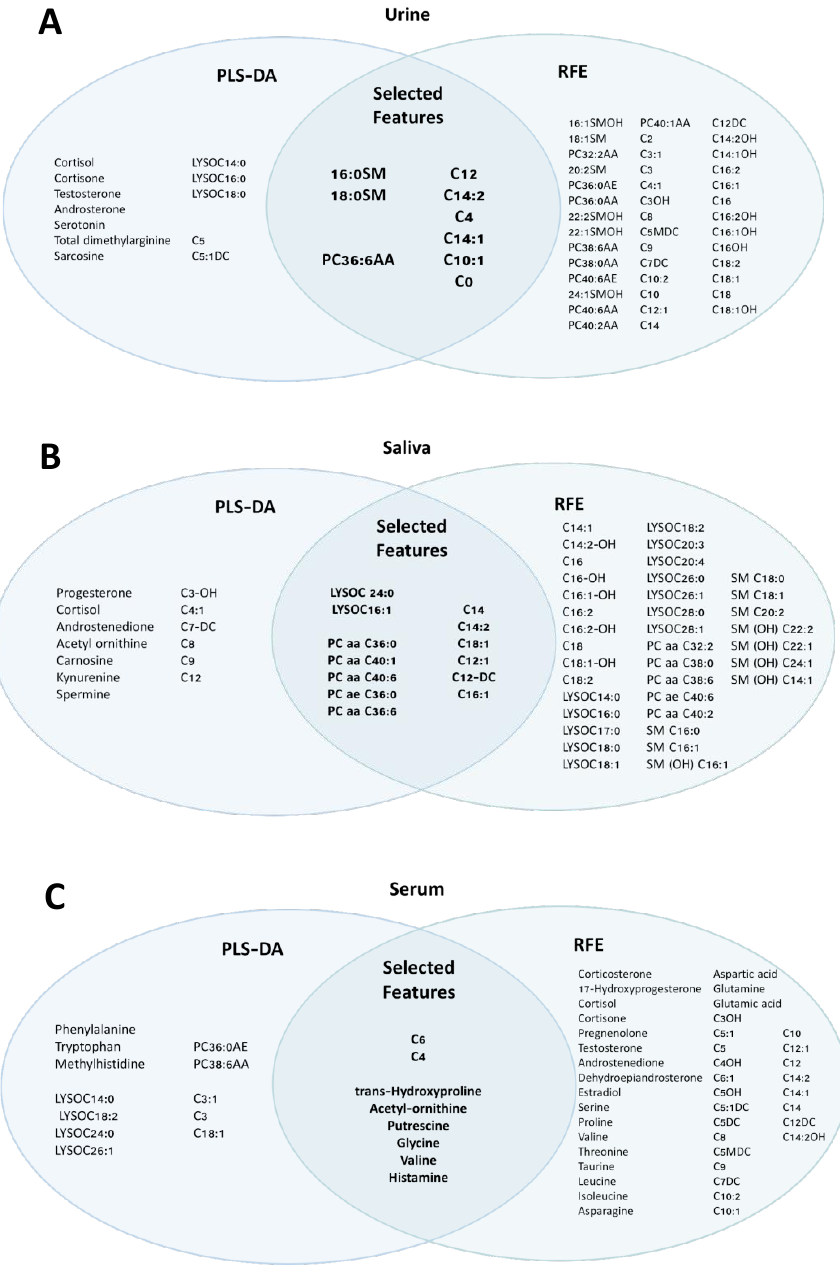
Figure 5. Selected features for ROC-AUC diagnostic classifier for urine ( A ), saliva ( B ), and serum ( C ). Features were selected via PLS-DA (VIP ≥ 1.25 + p < 0.05) and RFE.